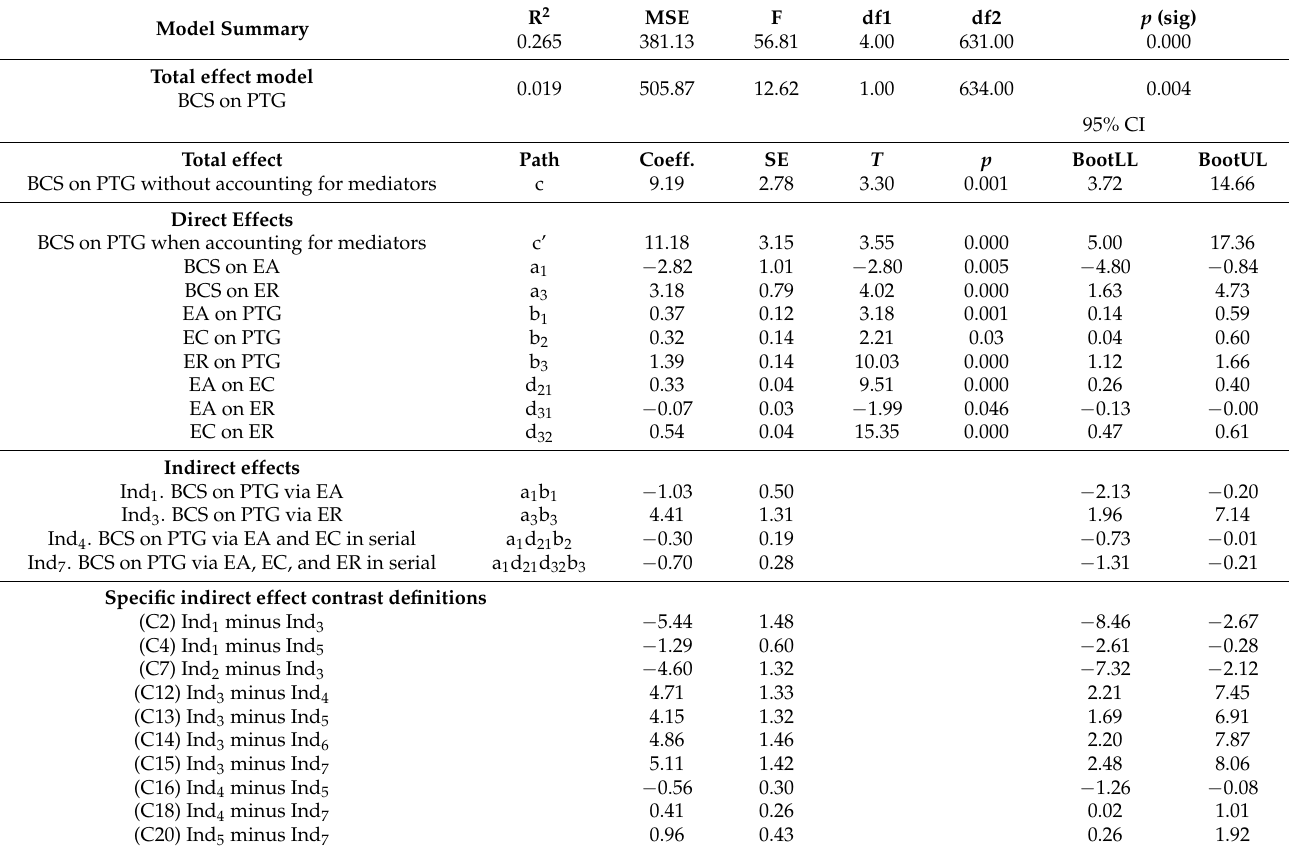
Table 3. Serial Multiple Mediator Model: Model summary and direct and indirect